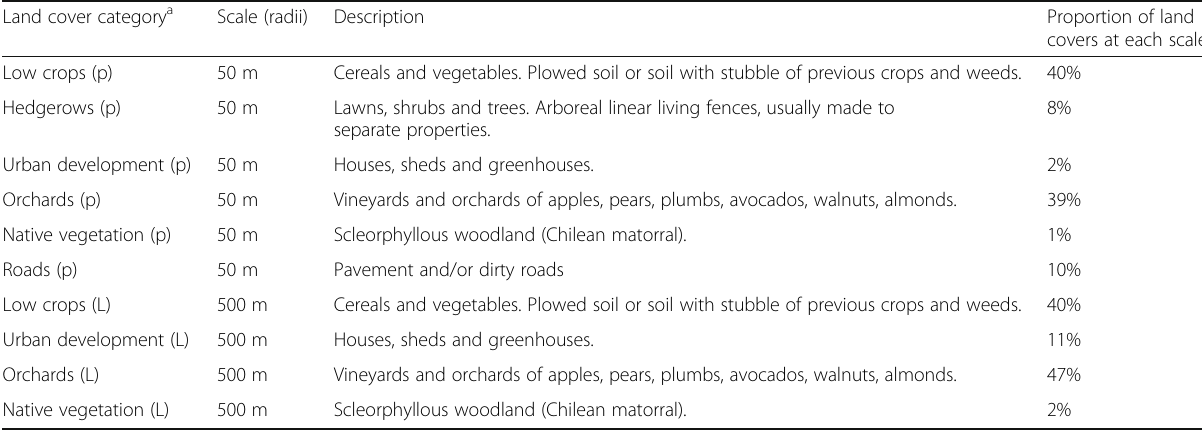
Table 1 Description of land cover classifications at plot (p) and landscape scale (L) of the study area and its proportion Land cover category a Scale (radii) Description Proportion of land